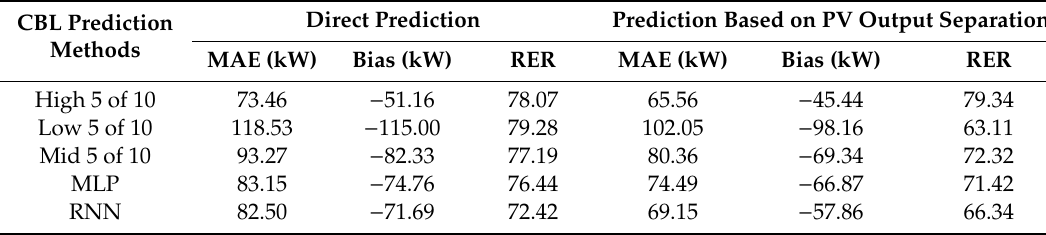
Table 4. Average evaluation results of CBL prediction for overall days under di ff erent